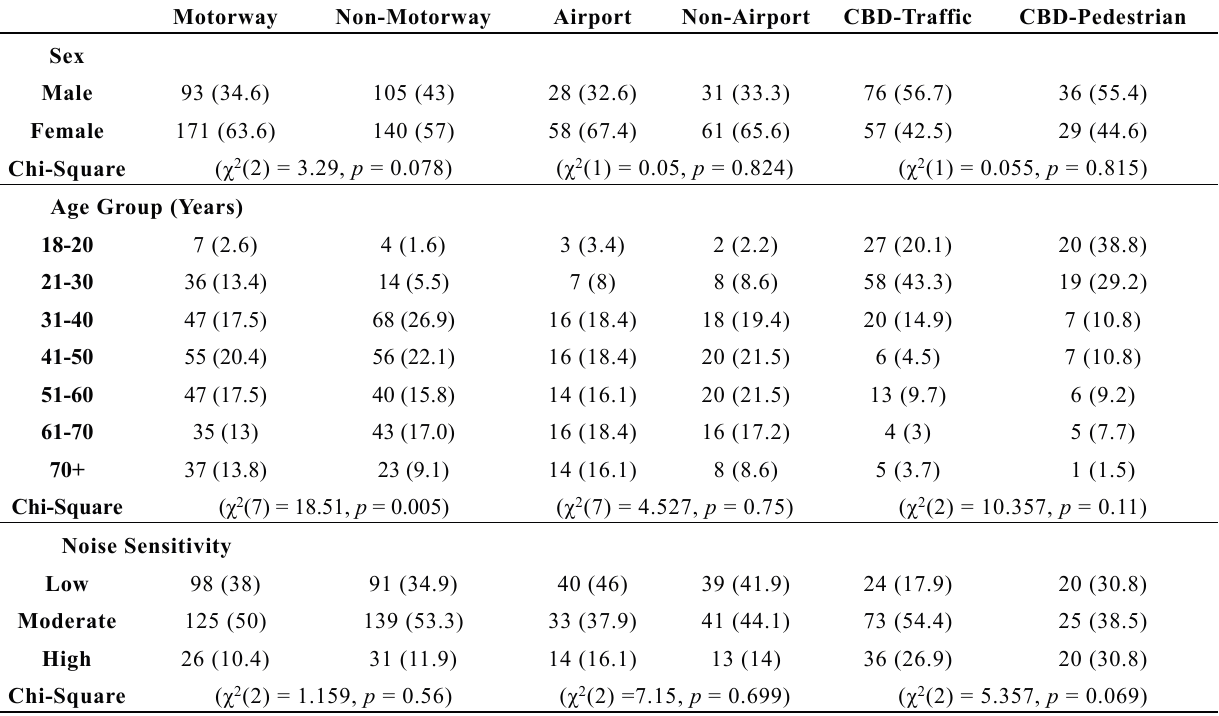
Table 3. Demographic profiles of the six samples. The values are raw frequencies with percentages presented in brackets. Differences in proportions between samples within a dataset are tested using Pearson’s chi-square tests. Note that percentages may be affected by missing